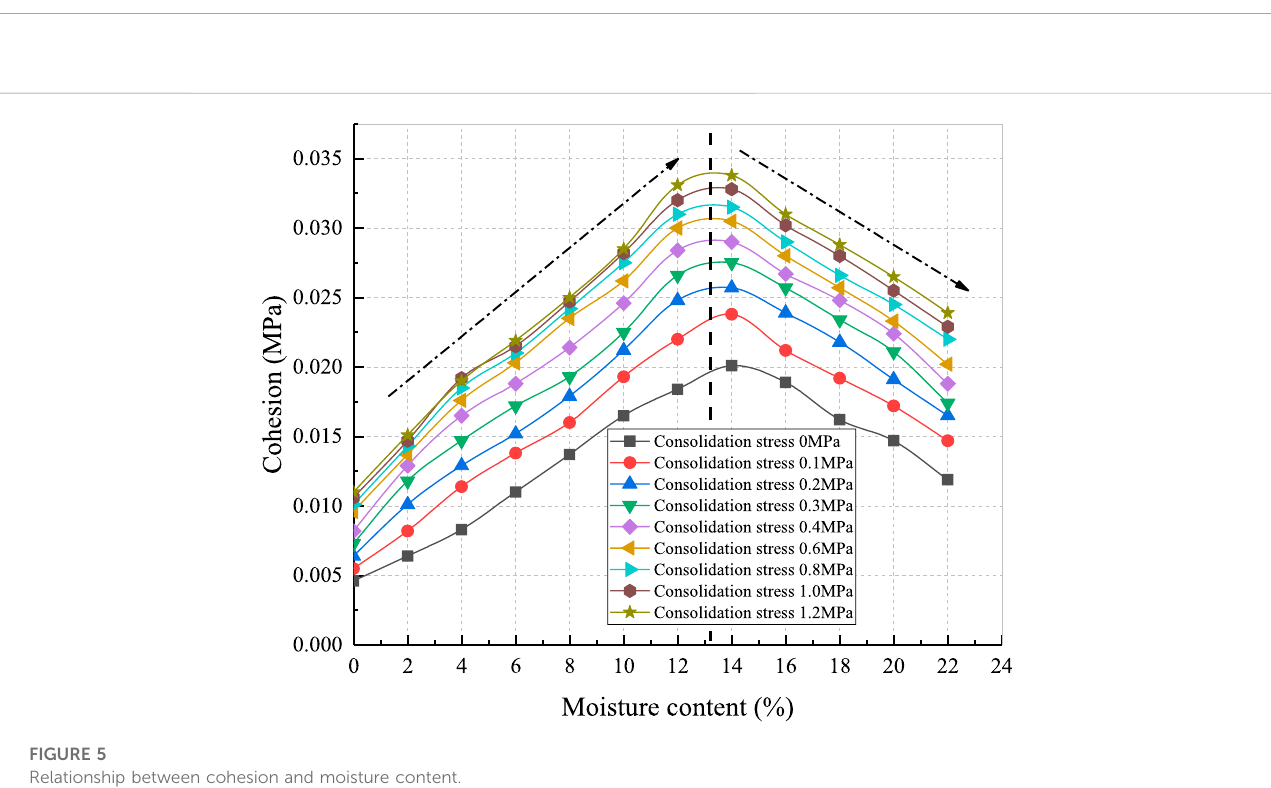
impact on the particle viscosity of the tailing sand and the pore water pressure, which also changed the shear strength index.